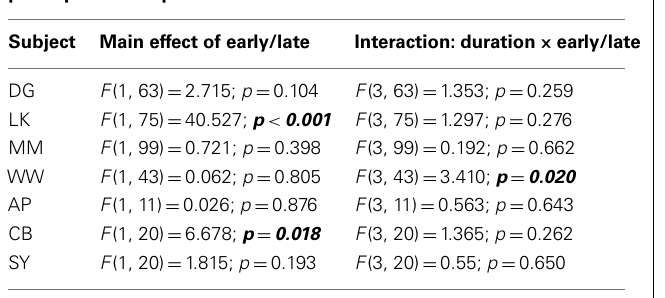
Table 2 | Results ofANOVA examining the effect of timing within trial (early vs. late) and its interaction with trial duration for all participants in experiments 2A and 2B.